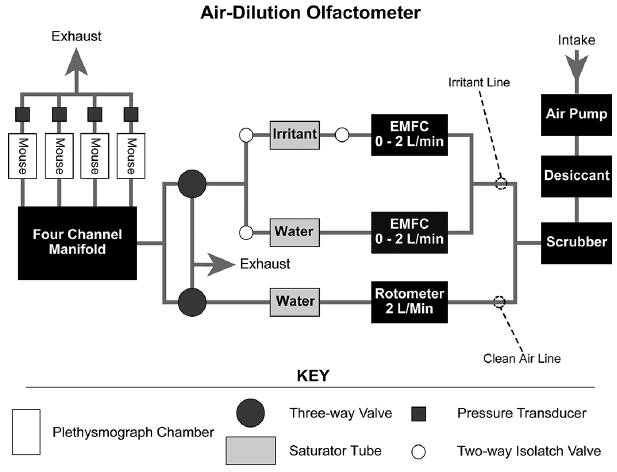
Figure 1. Diagram of the computer-controlled air-dilution olfactometer constructed to conduct the respiratory assay. EMFC, electronic mass flow